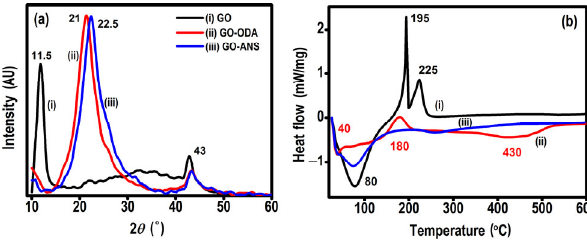
Fig. 4 (a) XRD patterns and (b) DSC curves of GO, GO-ODA and